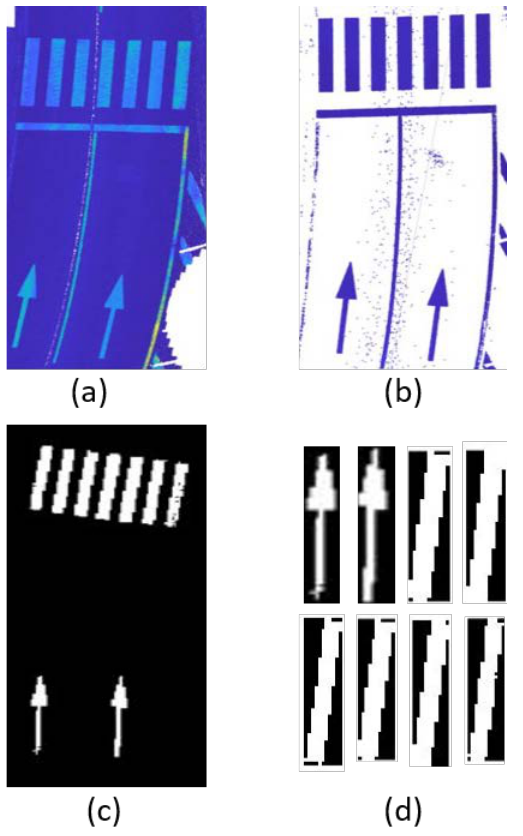
Figure 2. Road marking detection. (a) The intensity feature discriminates pavement points and road markings. (b) Point cloud after the application of an intensity filter. (c) Binary image representing road markings. (d) Each individual road marking in the binary image can be isolated for further